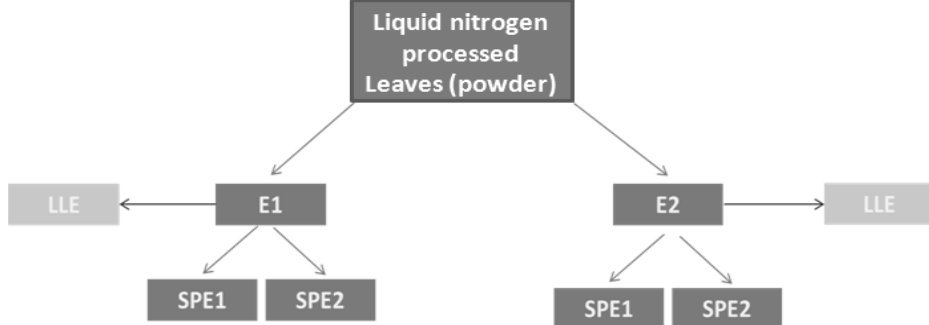
Figure 1. General scheme of the extraction and clean-up